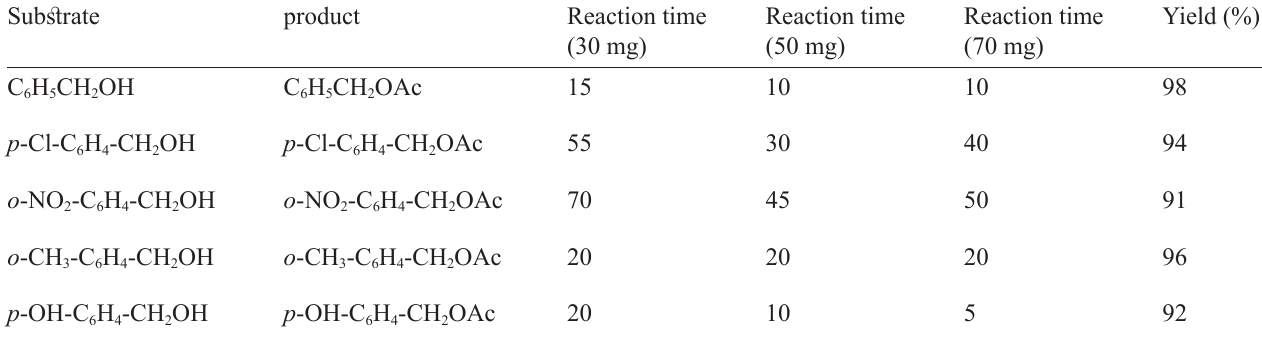
Table 2. Selective acetylation of benzyl alcohols in the presence of different concentrations of CdO nanocatalyst.